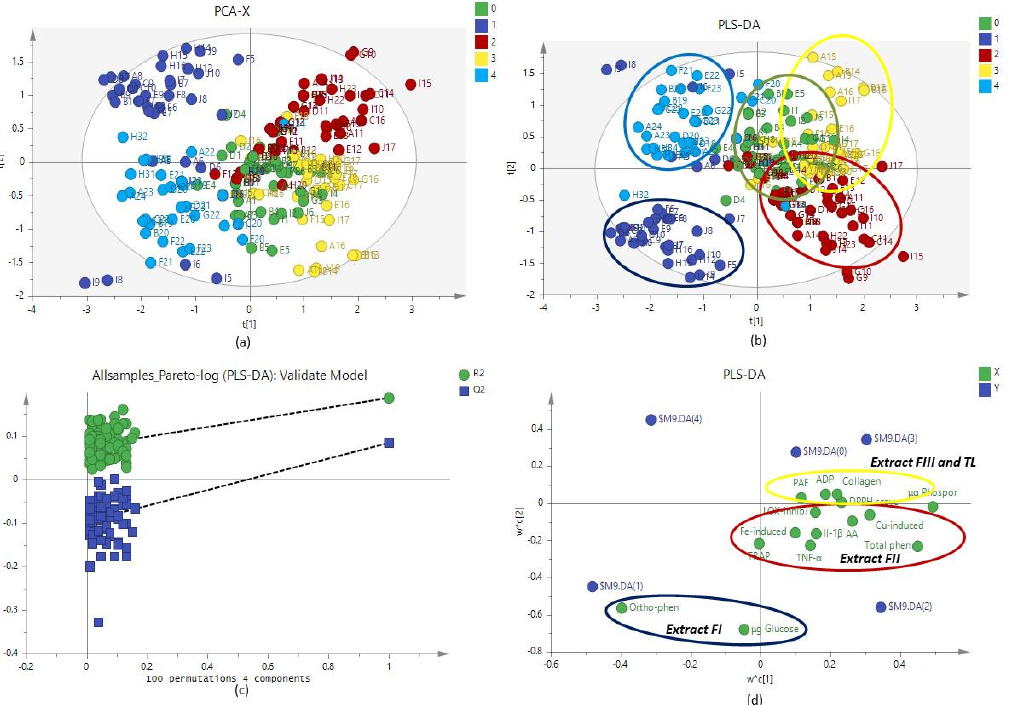
Figure 1. Graphs of the multivariate analysis: ( a ) PCA scores plot of fractions; ( b ) PLS-DA scores plot; ( c ) permutation test with 100 permutations for the PLS-DA model and ( d ) loading plot. 0: TL extract; 1: FI extract; 2: FII extract; 3: FIII extract; 4: FIV extract.